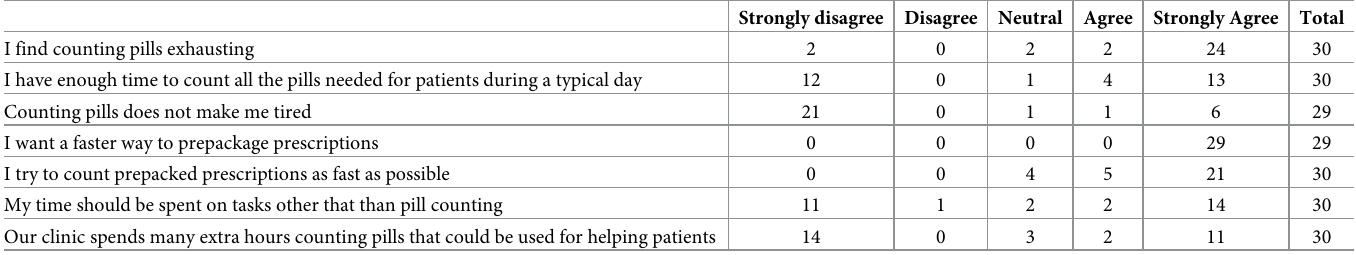
Table 3. Perceptions about pill counting.